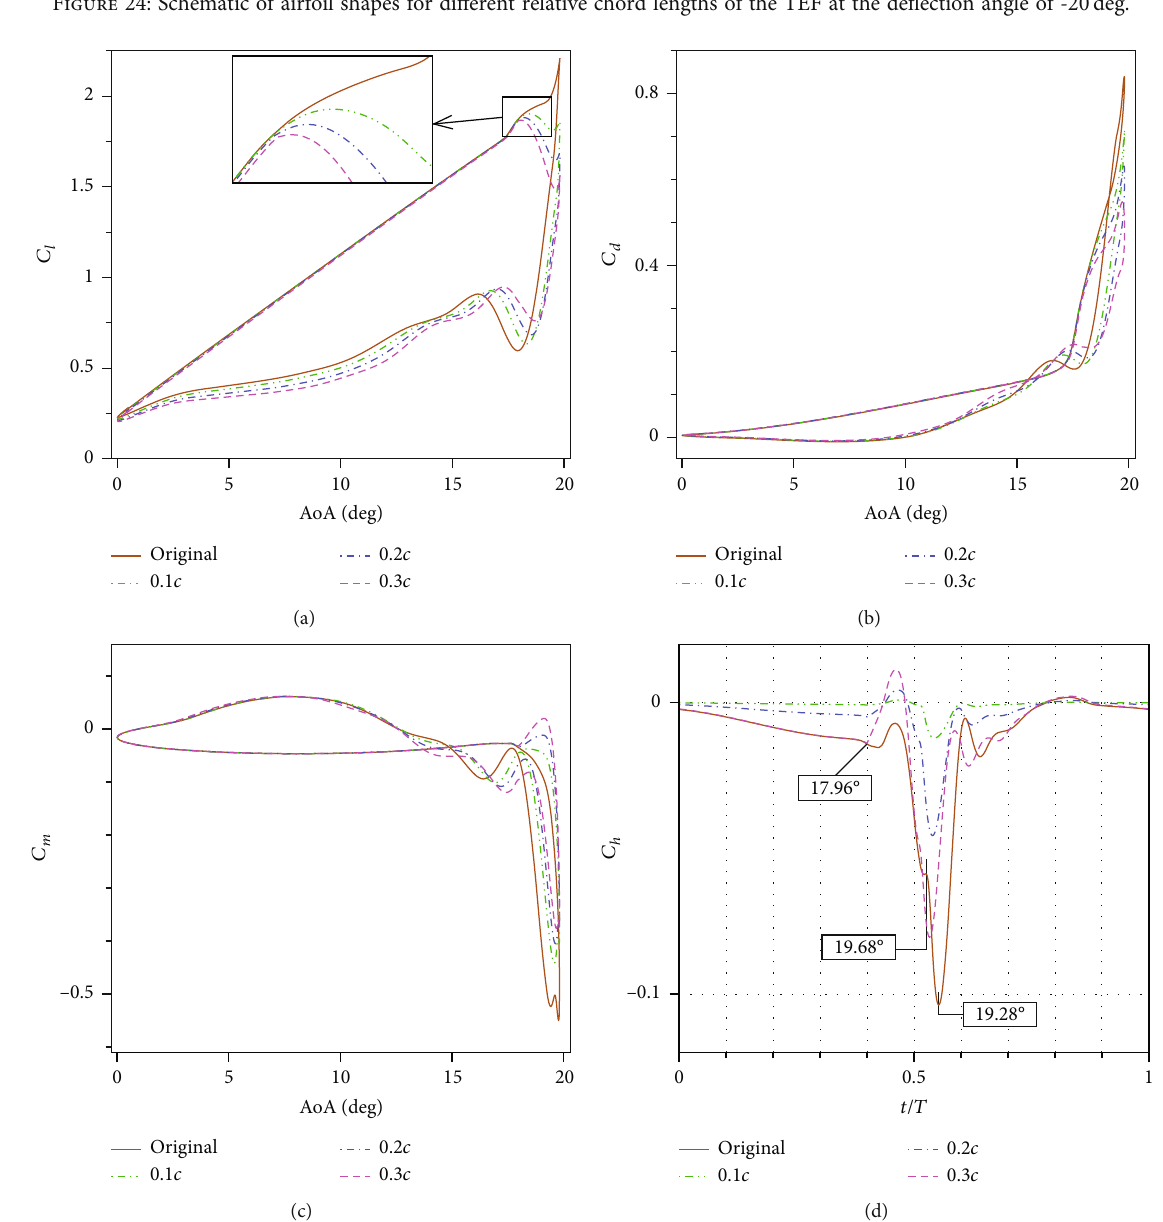
Figure 24: Schematic of airfoil shapes for di ff erent relative chord lengths of the TEF at the de fl ection angle of -20deg.